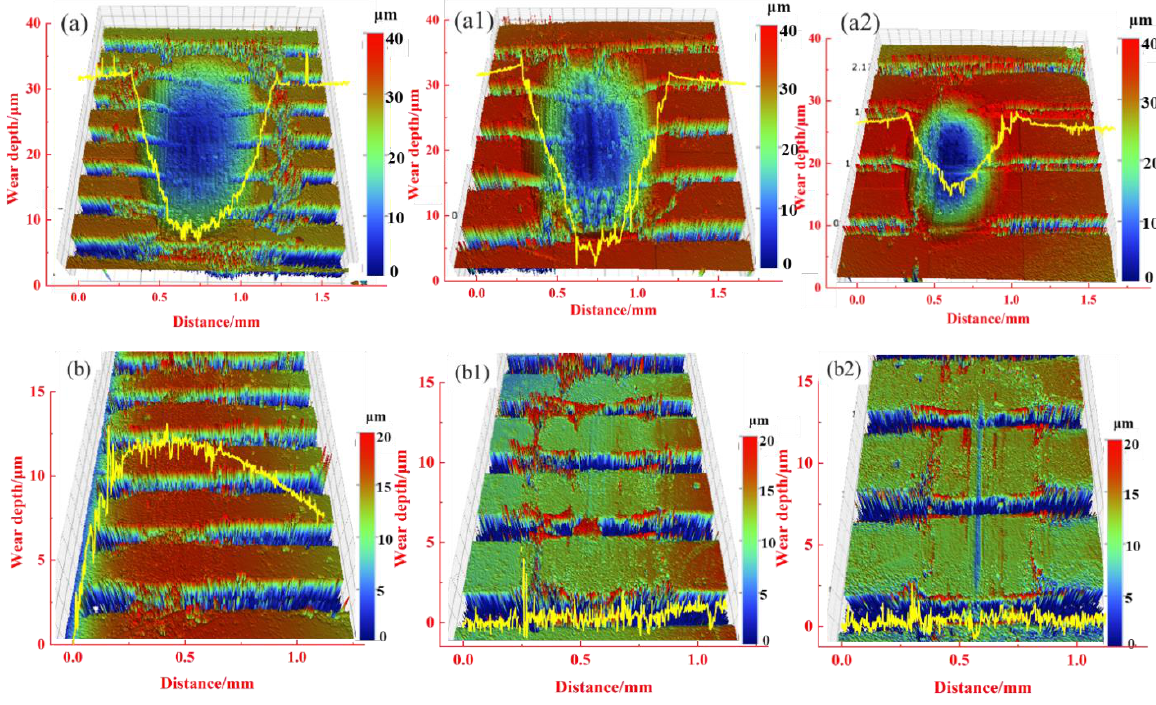
Figure 13. Morphology of the abrasion marks of Mn-Cu samples ( a ) T0.3-W0.1-C0.3, ( a1 ) T0.3-W0.1-C0.4, ( a2 ) T0.3-W0.1-C0.4 and Fe-Zn samples ( b ) T0.3-W0.1-C0.3, ( b1 ) T0.3-W0.1-C0.4, ( b2 ) T0.3-W0.1-C0.5.